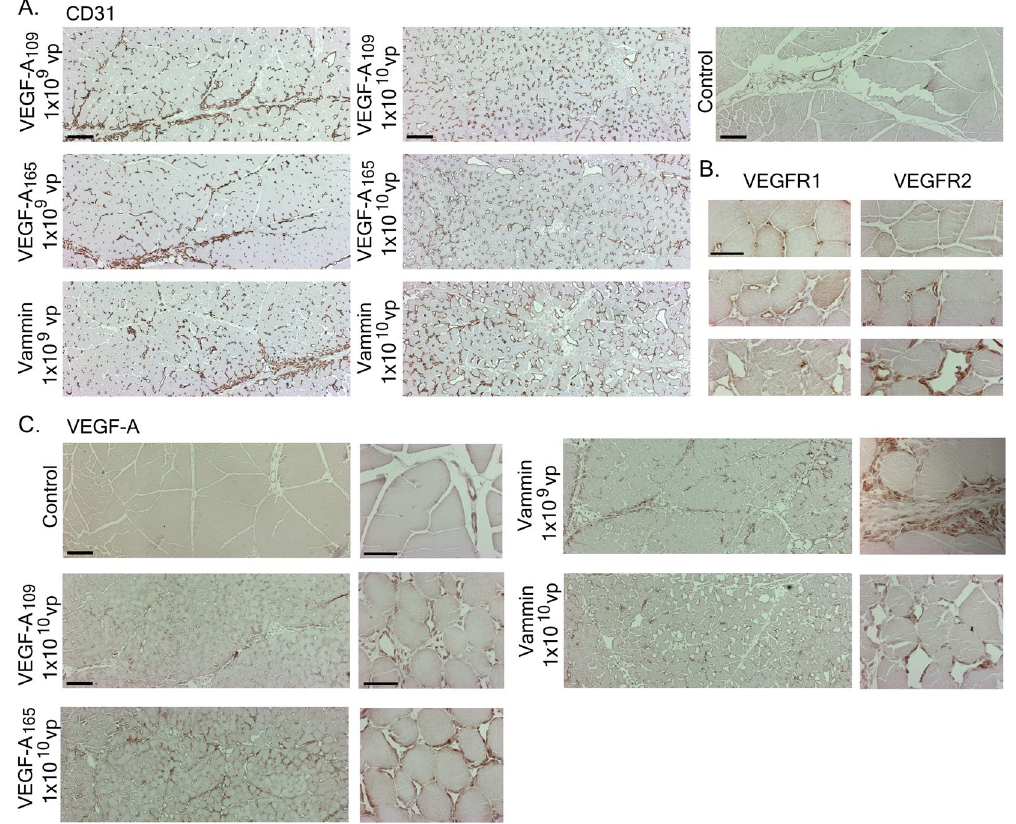
Figure 4. ( A ) Low magnification images from CD31 stained cross-sections of semimembranosus muscles show CD31 positive cells in the muscle perimysium in all 1 × 10 9 vp animals. With the 1 × 10 10 vp dose, enlargement of capillaries is uniformly seen inside the muscle fascicles. Scalebar 200 µ m. B. VEGFR-1 staining is intense in the small capillaries, but reduced in the heavily enlarged capillaries. VEGFR-2 staining is more intense in the enlarged capillaries. Pictures are from AdVammin 1 × 10 10 vp treated muscle from areas of low, medium and high effect. Scalebar 50 µ m. C. Diffuse VEGF-A staining is seen in 1 × 10 10 vp AdVEGF-A transduced muscles surrounding the capillaries especially in VEGF-A 165 muscles. The cells in the perimysium were strongly stained with VEGF-A also in AdVammin 1 × 10 9 vp transduced muscles suggesting that they may serve as a source of endogenous VEGF-A. VEGF-A is also detected around the highly enlarged capillaries in AdVammin 1 × 10 10 vp muscle. Scalebar 200 µ M in the low magnification (40x) images and 50 µ m in the high magnification (400x)